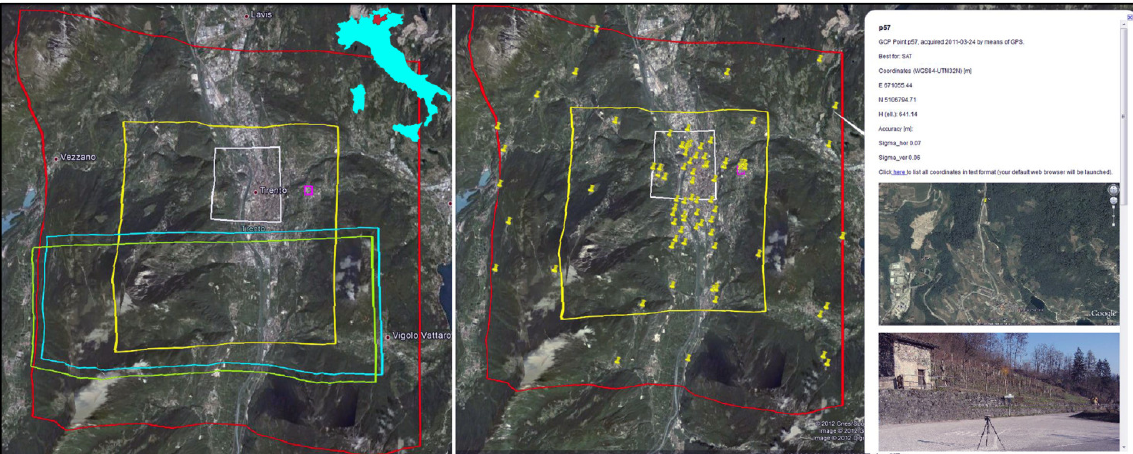
Figure 1. [Left] Approximate spatial extents of satellite and aerial imagery over the Trento testfield. The extents of each imagery type projected onto the DSM: WorldView-2 stereo-pair (red), GeoEye-1 stereo-pair (yellow), Quickbird scenes (green and cyan), aerial (white) and UAV (violet). SPOT imagery is not depicted, as it comprises the whole area. [Right] Distribution of ground points with respect to WorldView-2 (red) and GeoEye-1 (yellow) imagery extent, with corresponding metadata and photographic information. WorldView-2 scans in the coastal (400-450 nm), yellow (585-625 nm), red edge (705-745 nm) and near infrared-2 (860-1040 nm) spectral ranges. The images cover an area of 17.64×17.64 km and have an overlap of 100%. The images were provided with Rational Polynomial Coefficients (RPCs). provided. -